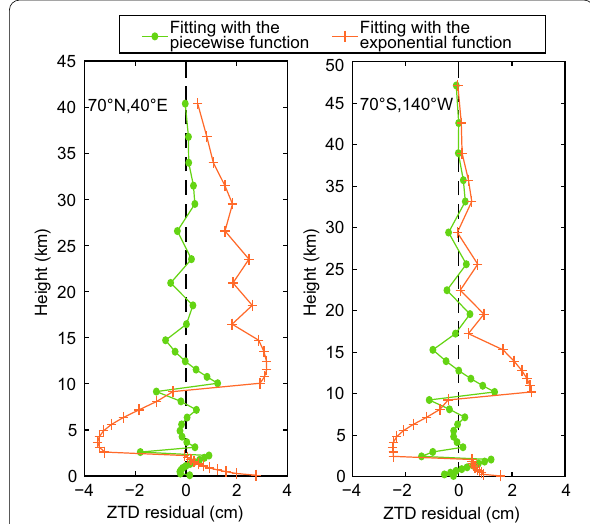
Fig. 2 The corresponding ZTD fit residual errors of the exponential function and piecewise